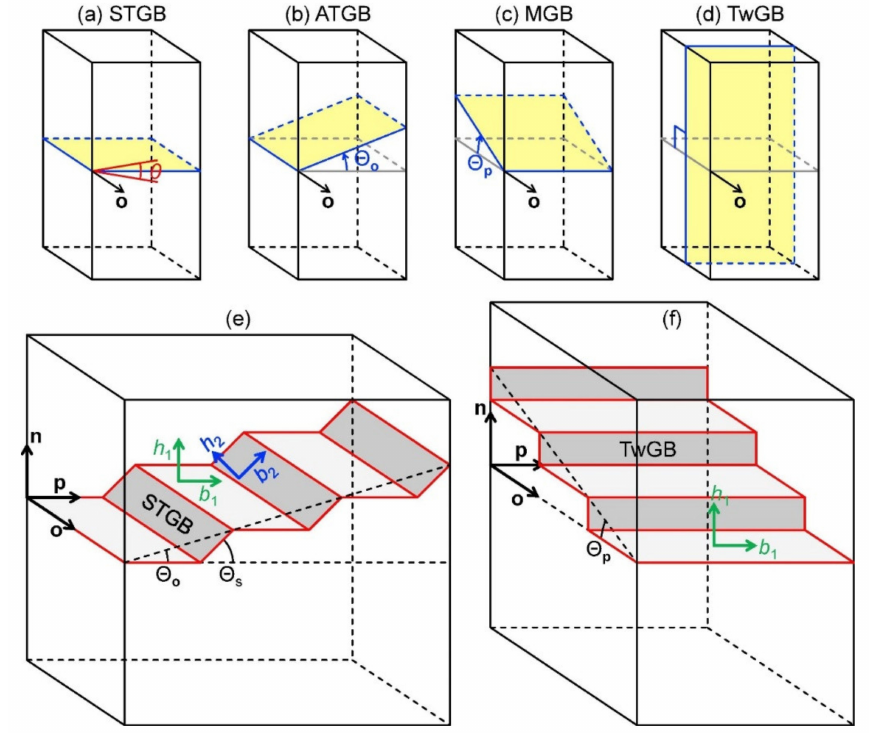
Figure 3. Schematic of macroscopic GB geometry ( a )symmetric tilt GB (STGB); ( b ) asymmetric tilt GB (ATGB); ( c ) mixed GBs (MGB); ( d ) twist GBs (twin GB); ( e ) facet structure of ( b ); ( f ) facet structure of ( c ) [51]. Figure 3 reprinted from Progress in Materials Science, 98, Jian Han, Spencer L.